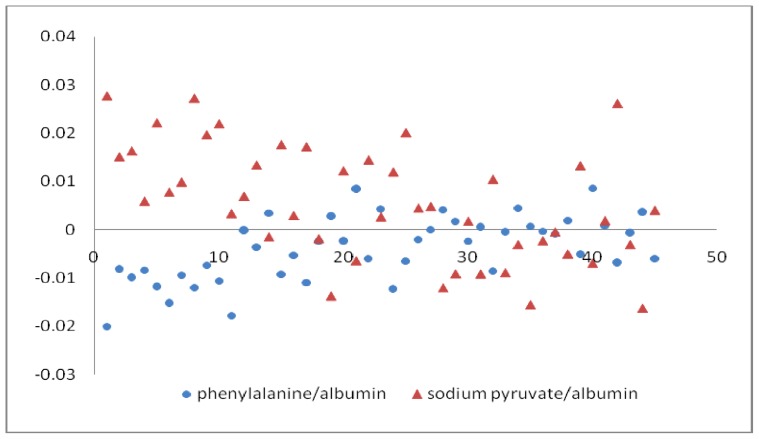
The distribution of 45 samples according to the two relative concentrations.